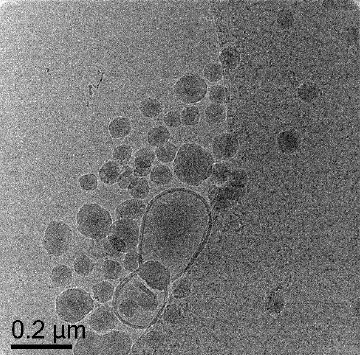
Figure 12. Cryo-TEM micrograph of Exp 8, polymerization of (DODAB- Oligo1 ) with MMA/EGDMA. Additional images in Figure S7.